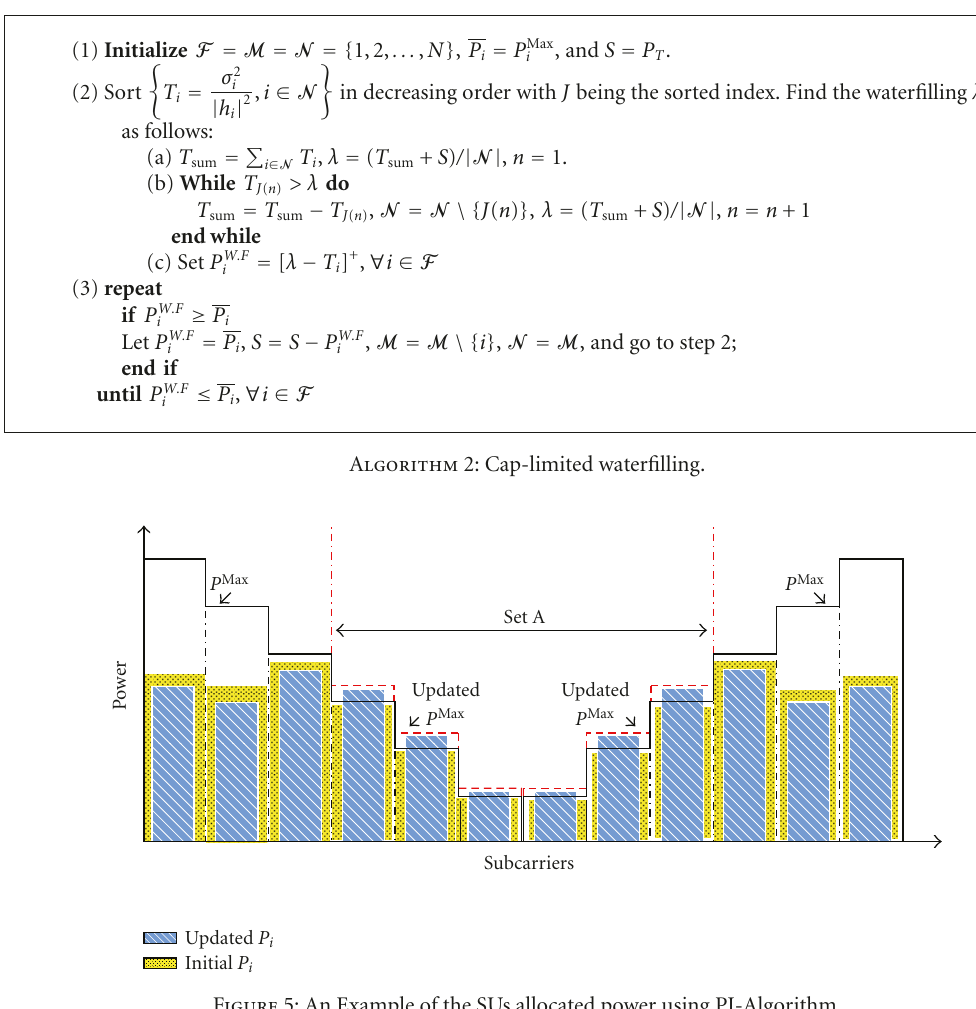
Figure 5: An Example of the SUs allocated power using